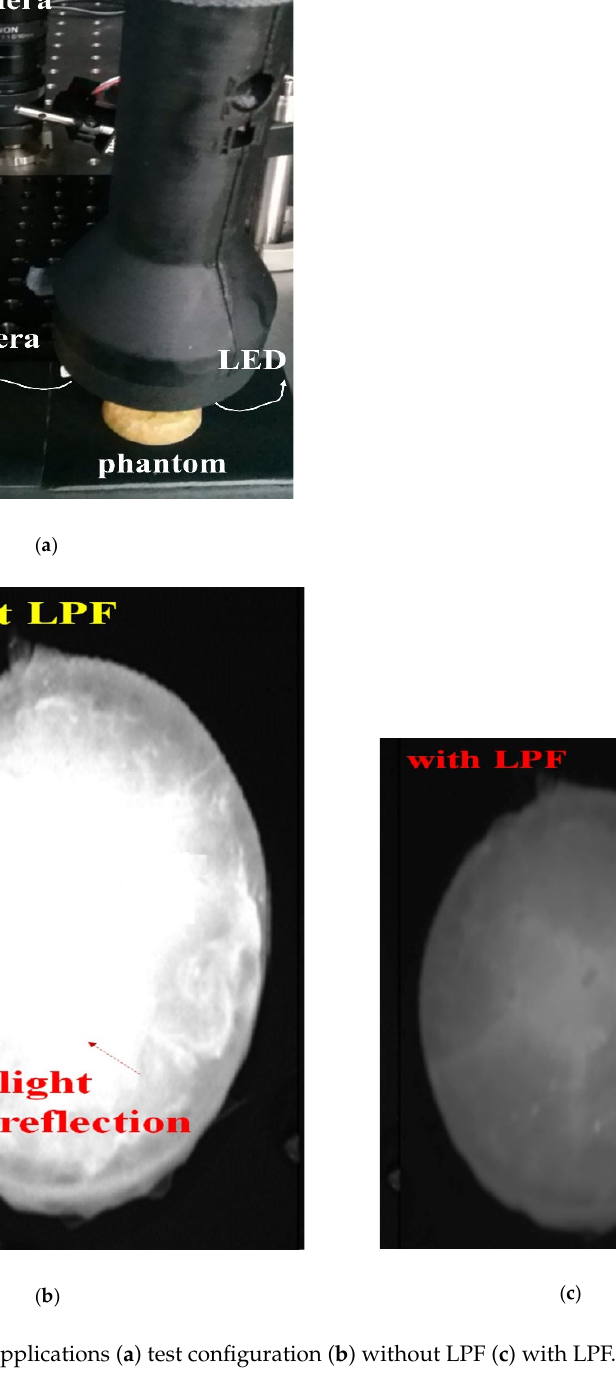
Figure 19. ROI numerical analysis of phantom experiment results for specular reflection removal. This is recommended as a method for fluorescence diagnosis in the future and is ex ‐ pected to be highly utilized. We also believe that these research methods will be fully applicable to the healthcare sector through product design and clinical trials in the future. In order to numerically observe the removal state of light reflection in the resulting images of Figures 16 and 19, it is necessary to obtain the speckle noise contrast evaluation